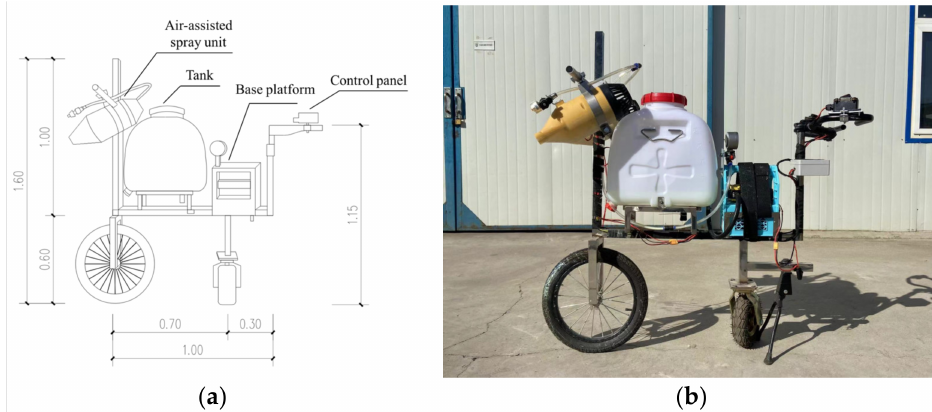
Figure 2. Structure of the ASS: ( a ) the design drawing of ASS; ( b ) the live picture of ASS.